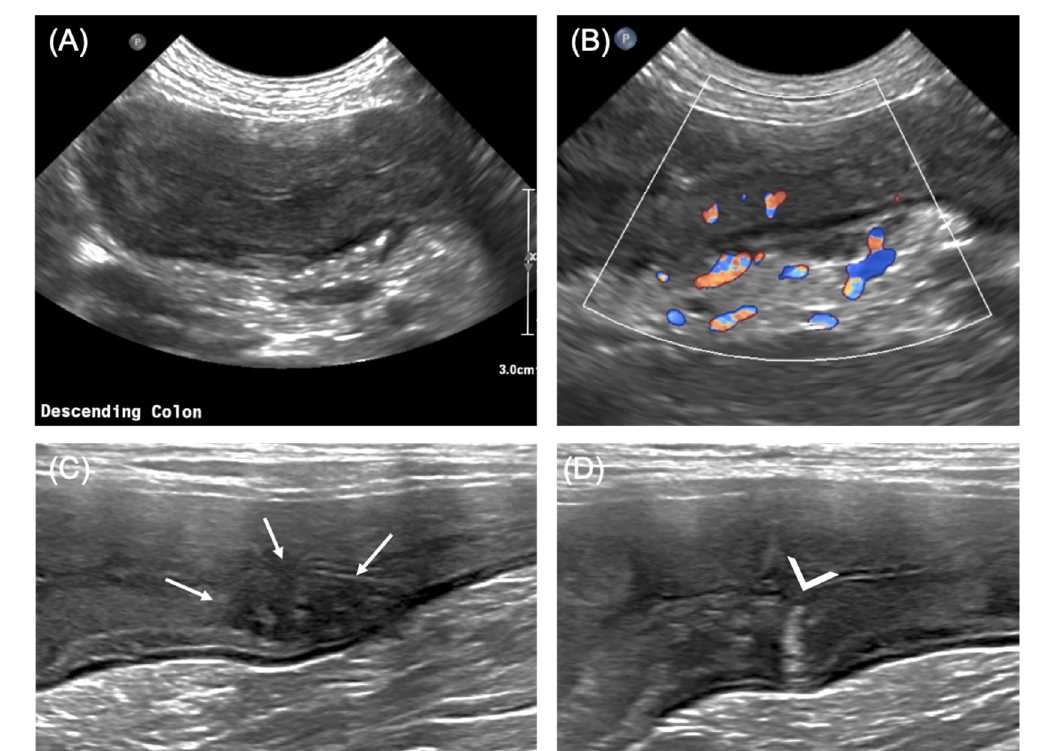
Figure 1. Bi-dimensional US features of the descending colon. ( A ) Appearance of the descending colon, transverse view; note the diffusely thickened wall, with partial loss of layering; ( B ) color Doppler flow at the level of the descending colon showing increased flow both within the wall and in the surrounding mesentery; ( C ) heterogeneously hypoechoic nodule in the colonic wall (arrows), apparently involving the mucosal and submucosal layers; ( D ) reverberating spot (arrowhead) arising from the mucosal surface at the level of the colonic wall, most likely representing a superficial ulceration. ( A , B ): micro-convex transducer (5–8 MHz); ( C , D ): linear transducer (8–14 MHz).